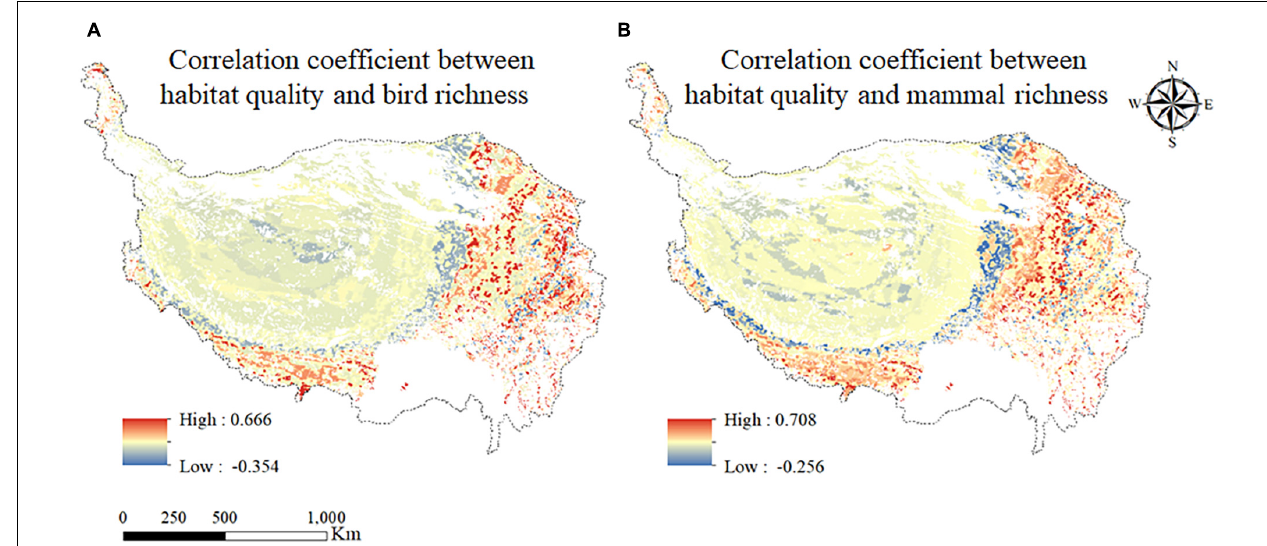
FIGURE 8 | Correlation coefficient between habitat quality and bird species richness (A) ; and between habitat quality and mammal richness (B)